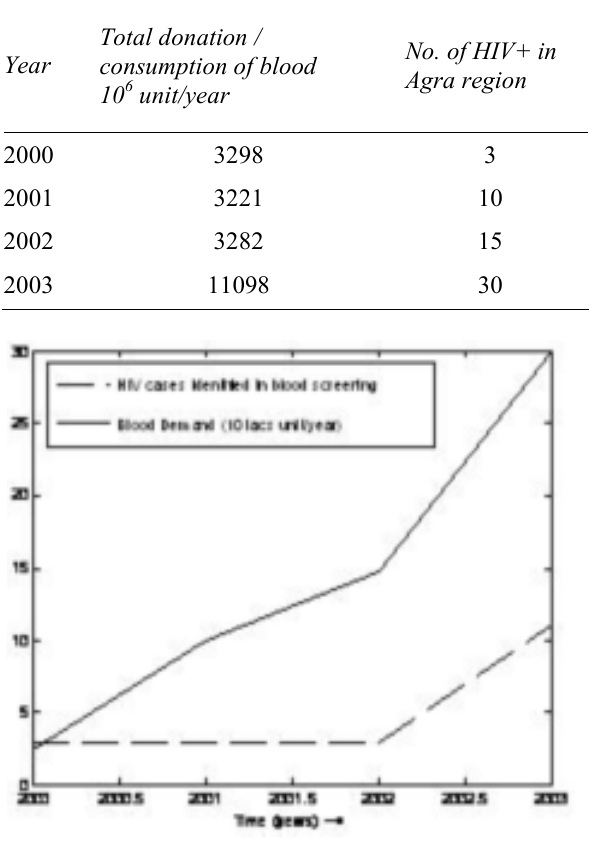
Figure 3: Trend of Blood Demand and HIV+ Cases High Risk Group